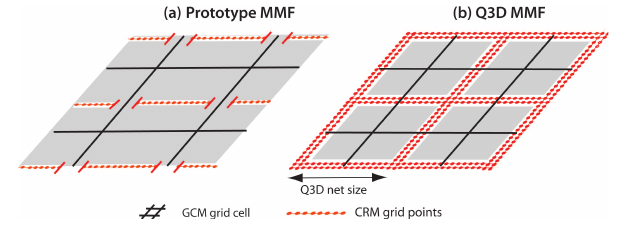
Fig. 11. Examples of grid-point arrays used in the Prototype and Q3-D MMFs.